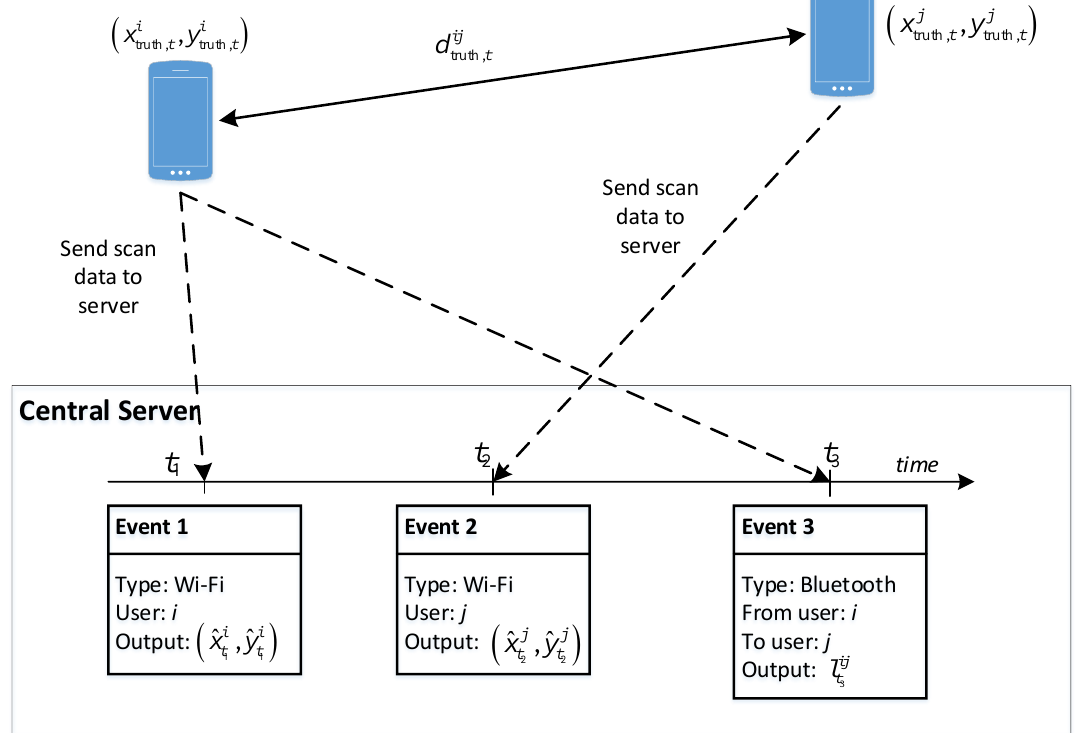
Figure 2. Data sent from two devices to the central server and derived information at the server for estimating each devices’ position.